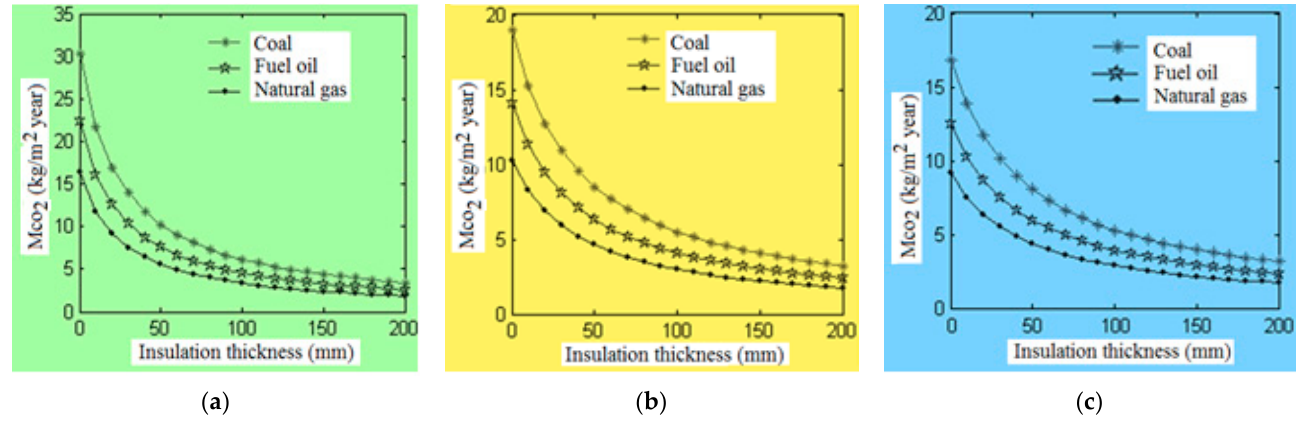
Figure 7. Correlation of CO 2 emission with insulation thickness for different fuel types: ( a ) Porous light brick wall; ( b ) Gas concrete wall; ( c ) Bims wall.